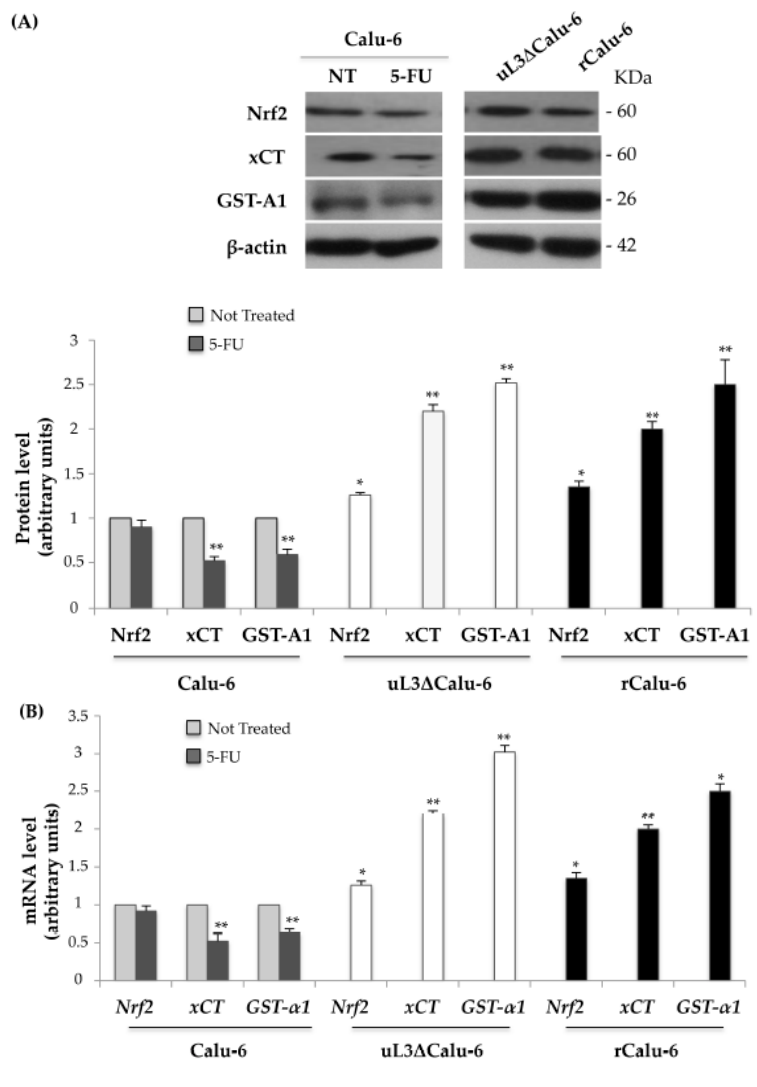
Figure 4. Influence of uL3 on Nrf2, xCT, and GST-A1 expression levels in Calu-6 cells and resistant sublines. ( A ) Protein extracts from Calu-6 cells treated or not with 10 µ M 5-FU for 48 h, uL3 ∆ Calu-6 and rCalu-6 cells were analysed by Western blotting with the indicated antibodies. Anti- β -actin was used as the loading control. The quantification of signals is shown. ** p < 0.01, * p < 0.05 vs. protein levels in untreated Calu-6 cells set at 1; ( B ) Total RNA from Calu-6 treated or not with 10 µ M 5-FU for 48 h, uL3 ∆ Calu-6 and rCalu-6 cells were subjected to qPCR with primers specific for the indicated genes. The quantification of signals is shown. ** p < 0.01,* p < 0.05 vs. mRNA levels in untreated Calu-6 cells set at 1.